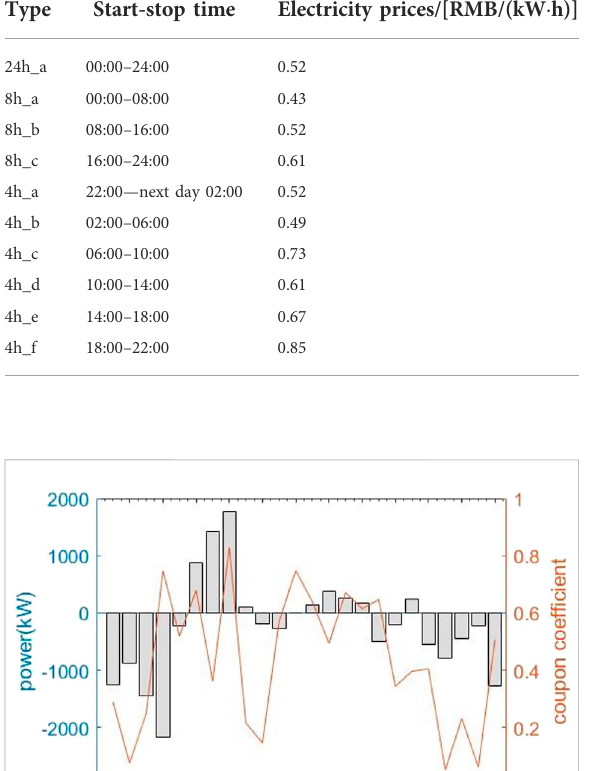
TABLE 2 Medium- and long-term bilateral contracts.